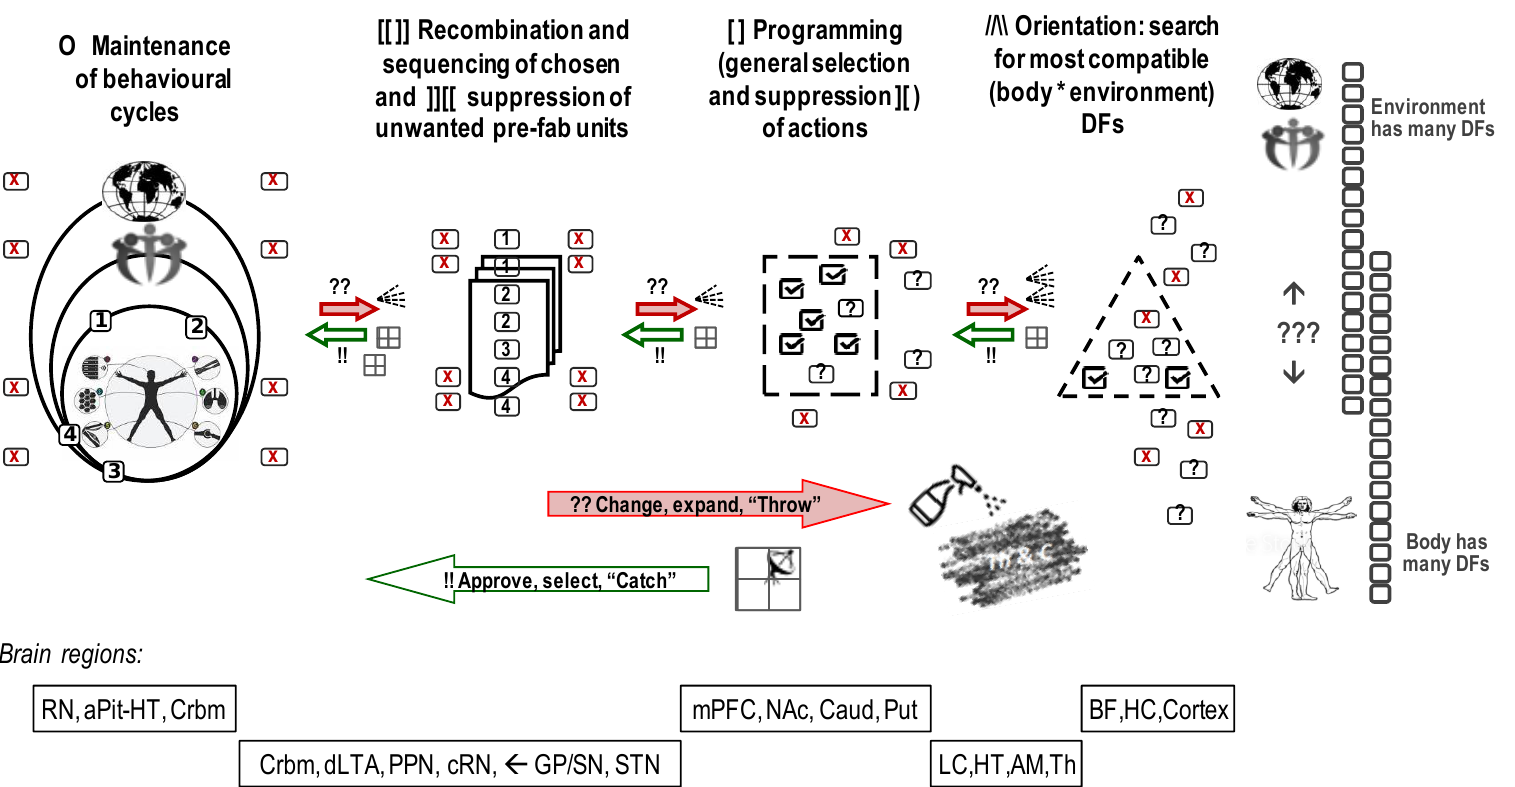
Figure 1. Action as a result of the selection of degrees of freedom (DF). This Figure uses symbols as formal notations for behavioural aspects. Constructivism suggests that behaviour starts from the maintenance of current cycles (denoted as O), and if the current behavioural alternatives do not fit the needs for cycle maintenance, behavioural regulation launches the re-integration of prefab (previously learned) actions (marked as [[]]). If prefab elements are insufficient, an integration of a new program of actions starts (marked as []), and if a program cannot be composed, then orientation processes increase (denoted as //\\). All these blocks are active all the time but to a different degree that depends on the complexity, novelty and uncertainty of situations and capacities of the individual. The lower level highlights the brain structures involved in the relevant stages of action construction: RN – raphe nucleus; mPFC — medial) prefrontal cortex;